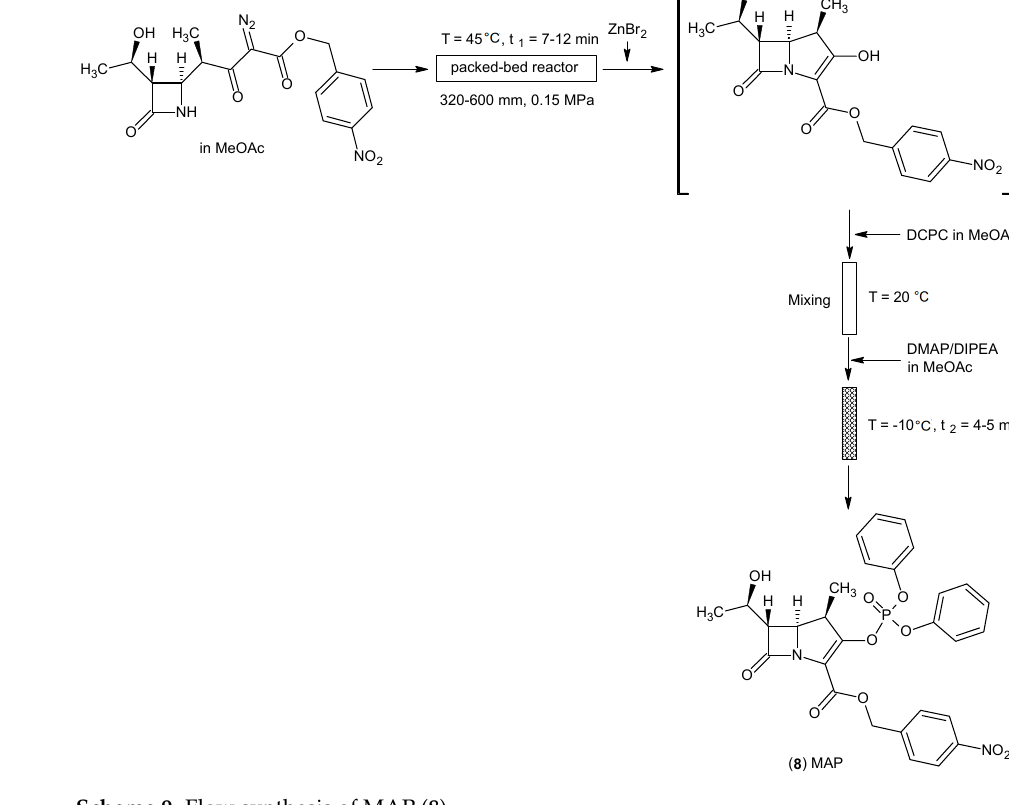
Scheme 9. Flow synthesis of MAP ( 8